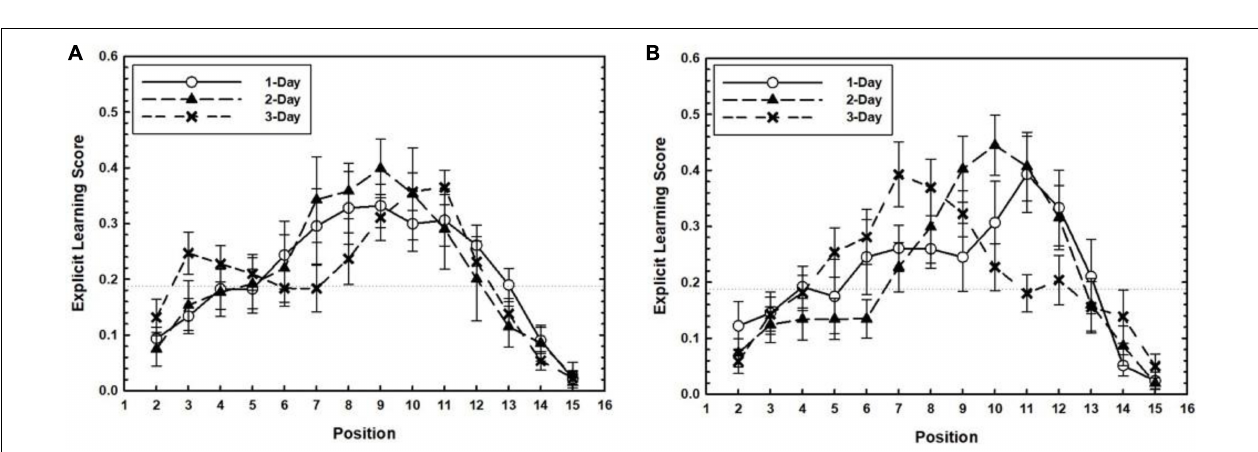
significant, p s > 0.5. Also, no effects were found for target position 4. Comparing the 7–13 condition with the random condition revealed a marginally significant effect of training level for target position 7, F (2,75) = 3.15, p = 0.048, η p 2 = 0.07. The effects subsuming Target Timing were not